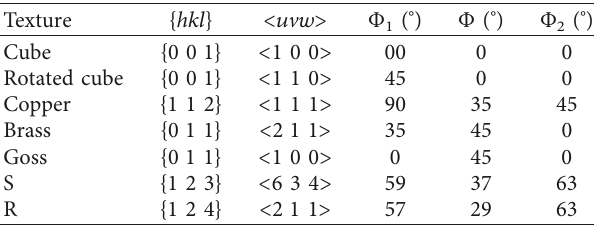
Figure 1: True stress-true strain curves of 7B04 Al alloy after superplastic deformation under different parameters: (a) 470 ° C; (b) 485 ° C; (c) 500 ° C; (d) 515 ° C; (e) 530 ° C [52]. Table 1: Main texture components in FCC